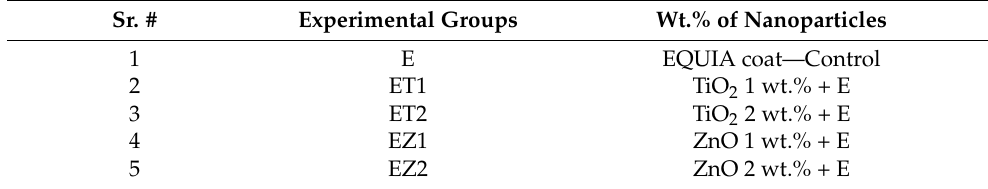
Table 1. Composition and abbreviations of control and experimental groups used. Sr.